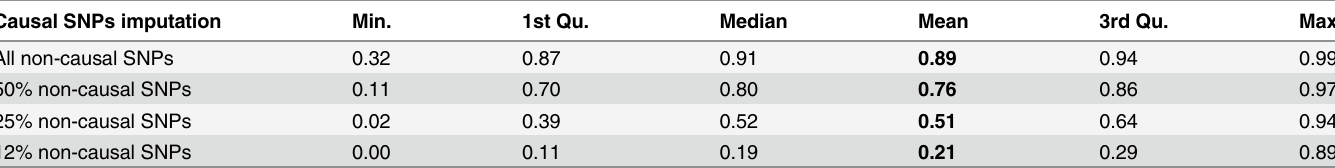
Table 3. Effects of SNP removal on prediction of masked causal SNPs using imputation based upon subsets of the 452,696 pruned SNPs. Causal SNPs imputation